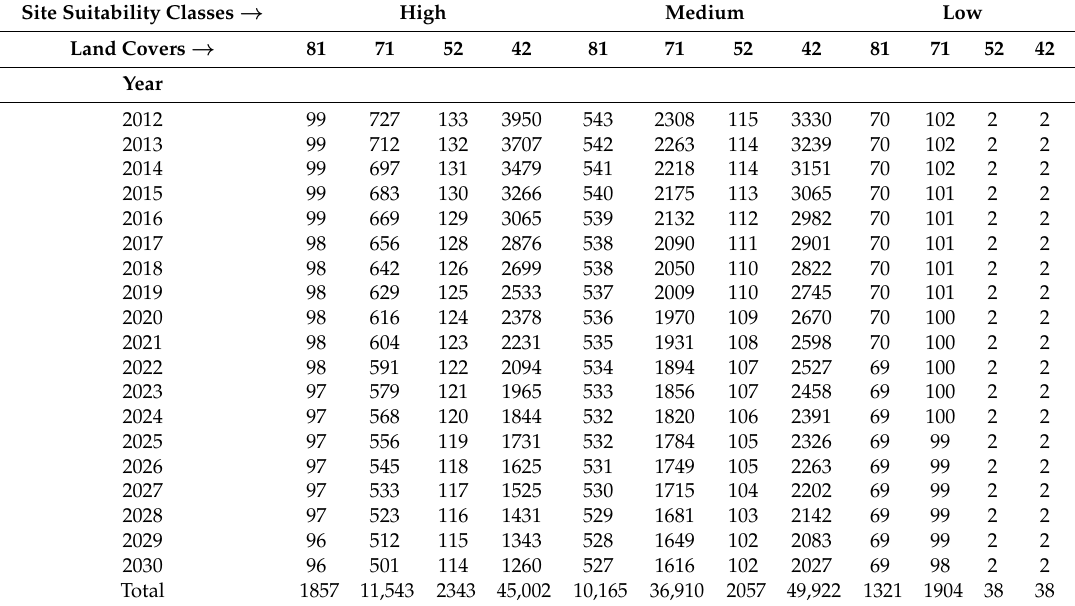
Table A1. Total Number of Pixels Transitioning Each Year (High Demand